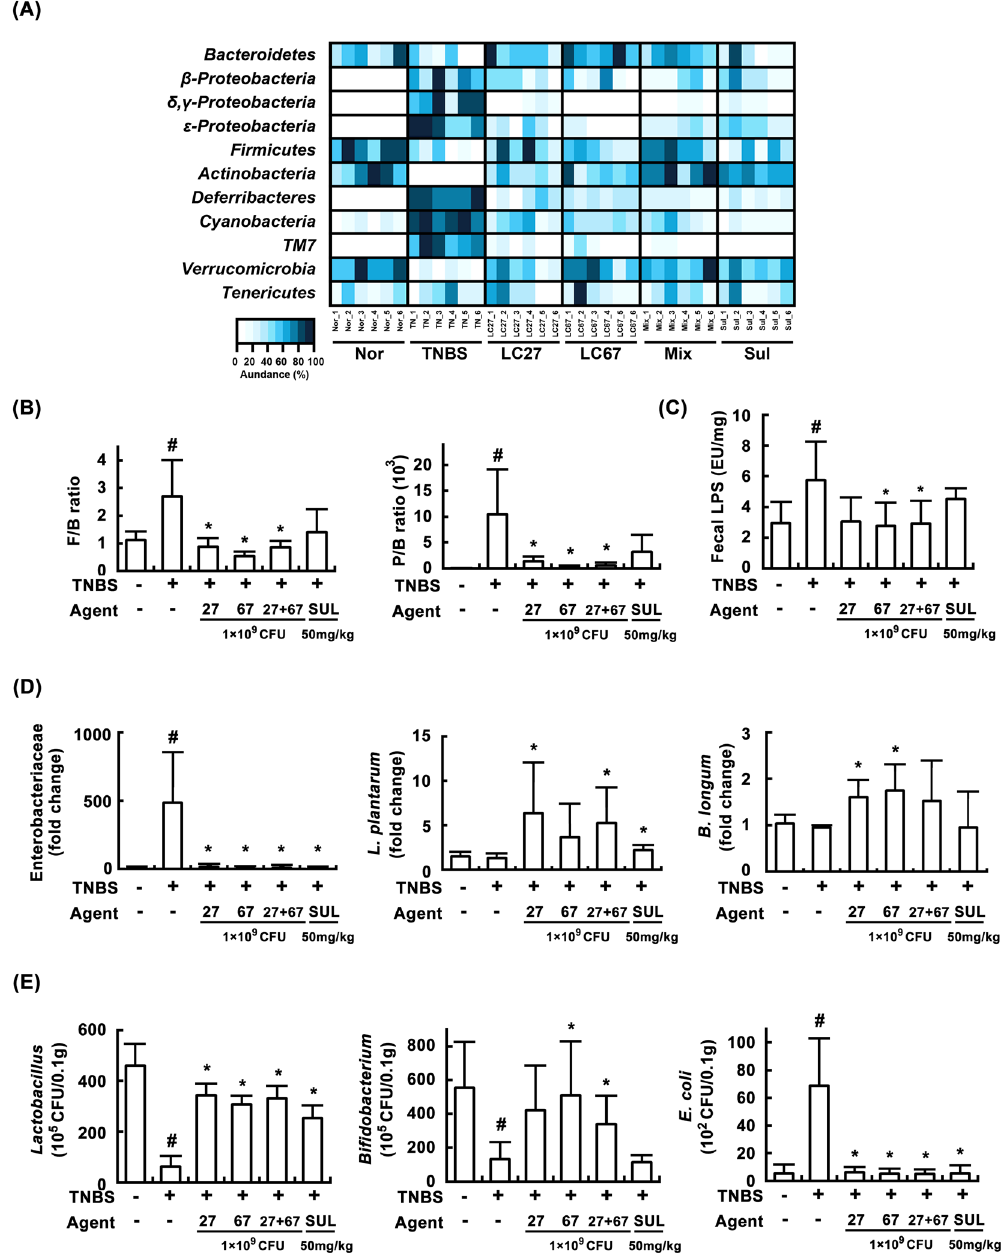
Figure 8. Effects of LC27, LC67, and PM on gut microbiota composition in mice with TNBS-induced colitis and liver injury. ( A ) Effects on gut microbiota, assessed by qPCR. ( B ) Effects on the ratio of Firmicutes to Bacteroidetes (F/B) and Proteobacteria to Bacteroidetes ratio (P/B). ( C ) Effects on gut microbiota LPS levels, assessed by LAL assay kit. ( D ) Effects on the populations of Enterobacteriaceae, Lactobacillus plantarum , and Bifidobacterium longum , assessed by qPCR. ( E ) Effects on the levels of Lactobacillus sp., Bifidobacterium sp., E . coli , assessed by the culture of selective media. Test agents and saline were orally administered for 3 days after TNBS treatment. TNBS, except in the normal control group, was intrarectally administered to mice and test agents [saline, LC27, LC67, PM (1 × 10 9 CFU/mouse), or sulfasalazine (SS; 50 mg/kg)] were orally administered for 3 days. All values are shown as mean ± SD (n = 6). # p < 0.05 vs. normal control group. * p < 0.05 vs. group treated with TNBS